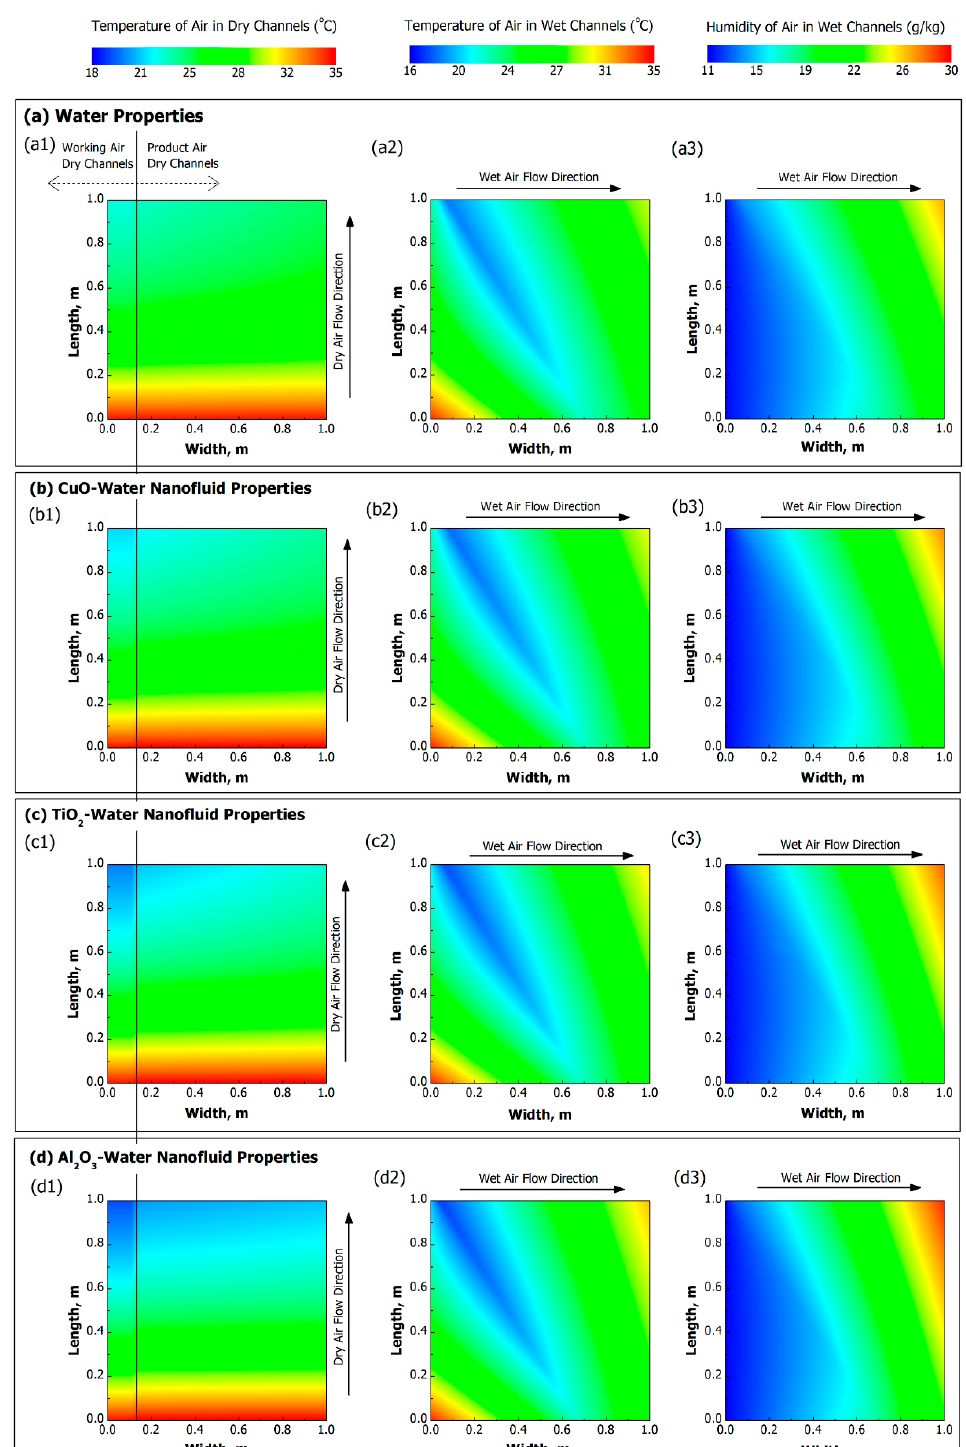
Figure 6. ( a1 – a3 ) Temperature distribution of product air and working air and humidity distribution of working air, respectively, using water properties. ( b1 – b3 ) Temperature distribution of product air and working air and humidity distribution of working air, respectively, using CuO–water nanofluid properties. ( c1 – c3 ) Temperature distribution of product air and working air and humidity distribution of working air, respectively, using TiO 2 –water nanofluid properties. ( d1 – d3 ) Temperature distribution of product air and working air and humidity distribution of working air, respectively, using Al 2 O 3 –water nanofluid properties.